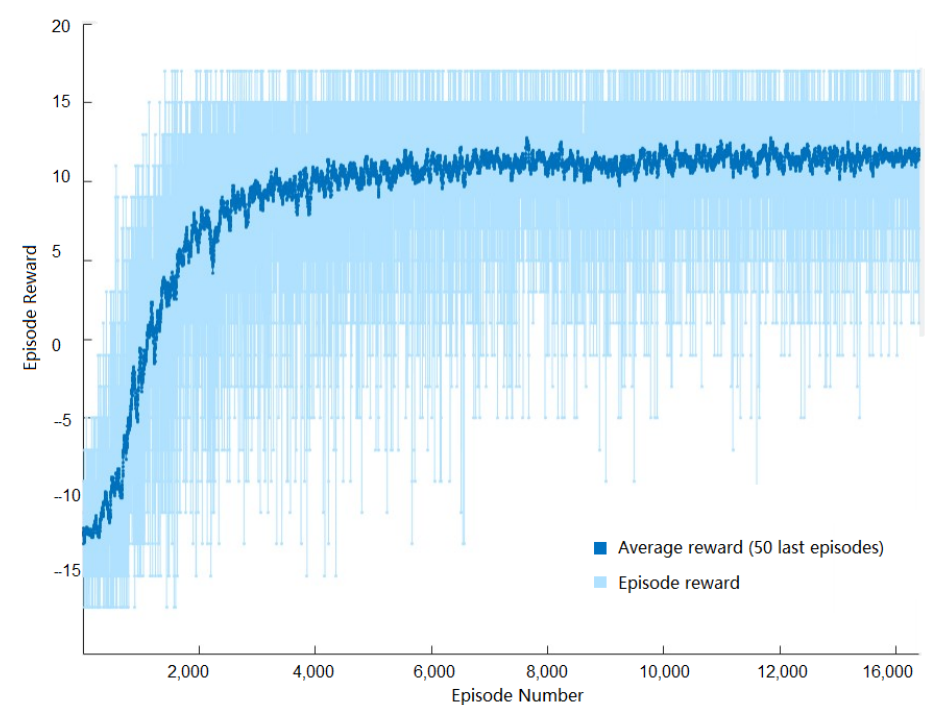
Figure 3. Sample of episode rewards versus episode numbers during the training of one user.